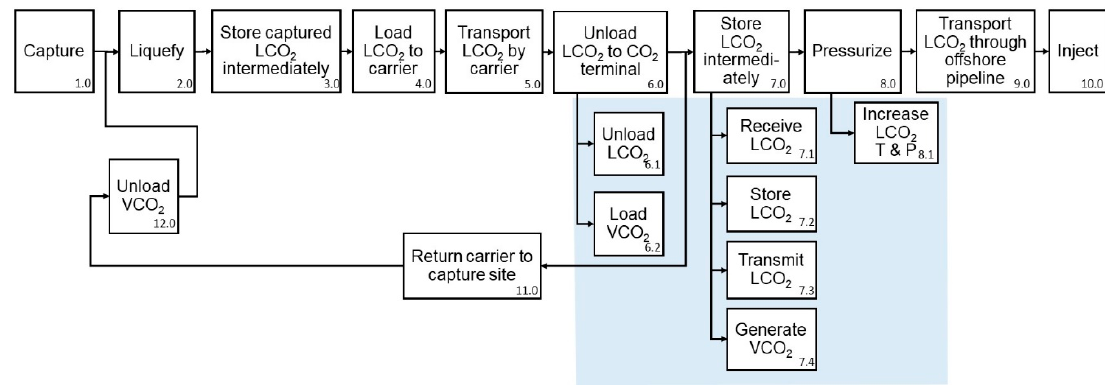
Figure 5. A functional flow block diagram of CCS project and scope of CO 2 terminal functions (blue region).